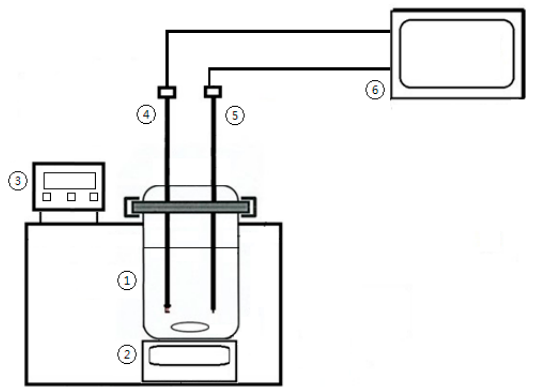
Figure 1. Schematic diagram of the experimental apparatus: ( 1 ) 250 mL crystallizer; ( 2 ) magnetic stirrer; ( 3 ) constant temperature water bath; ( 4 ) turbidity probe; ( 5 ) temperature probe; ( 6 ) computer.